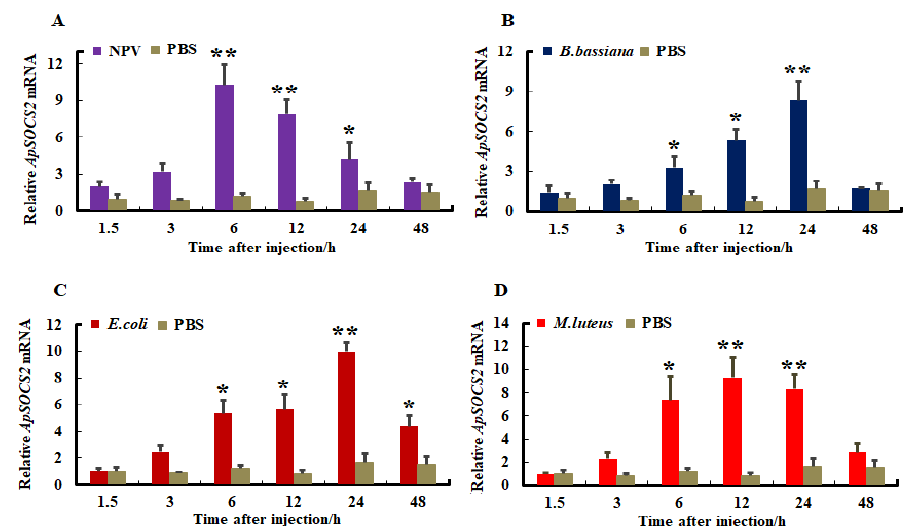
Figure 6. The mRNA expression levels of ApSOCS-2 in hemocytes following microbial challenge normalized to 18 S and actin-1 (Actin-1 normalized: Figure S4). Following injection of ( A ): ApNPV, ( B ): B. bassiana , ( C ): E. coli , ( D ): M. luteus , the mRNA expression levels of ApSOCS-2 were analyzed using qRT-PCR. Data of triplicate experiments (n = 3) are represented with mean ± S.E. Asterisks indicate significant differences (* p < 0.05, ** p <